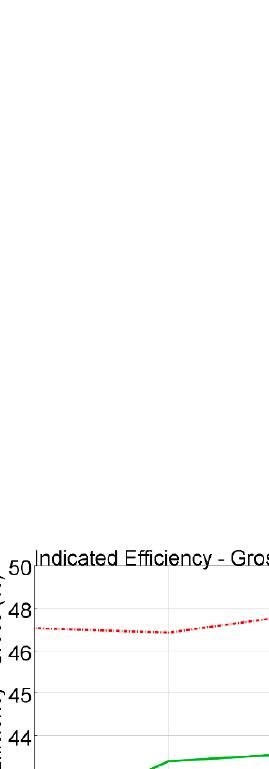
Figure 10. BMEP ( a ) and GIMEP ( b ) comparison between base diesel engine, 4-stroke RCCI engine and 2-stroke RCCI engine. Operating point 1500–3500 rpm at full load. and 2-stroke RCCI engine. Operating point 1500–3500 rpm at full load.